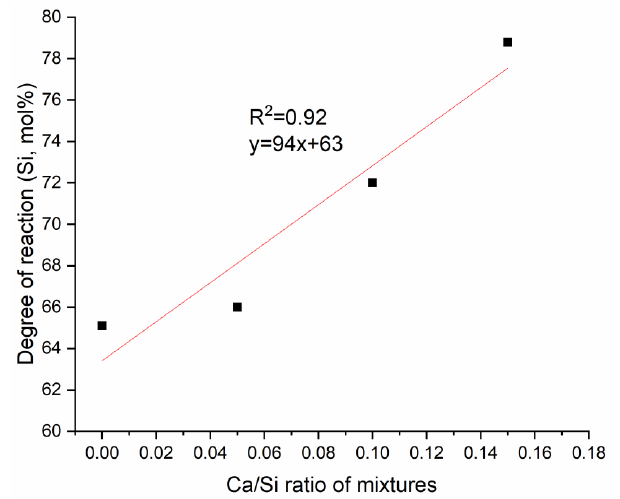
Figure 6. 29 Si NMR spectra of geopolymers at 7 days with different amounts of Ca.